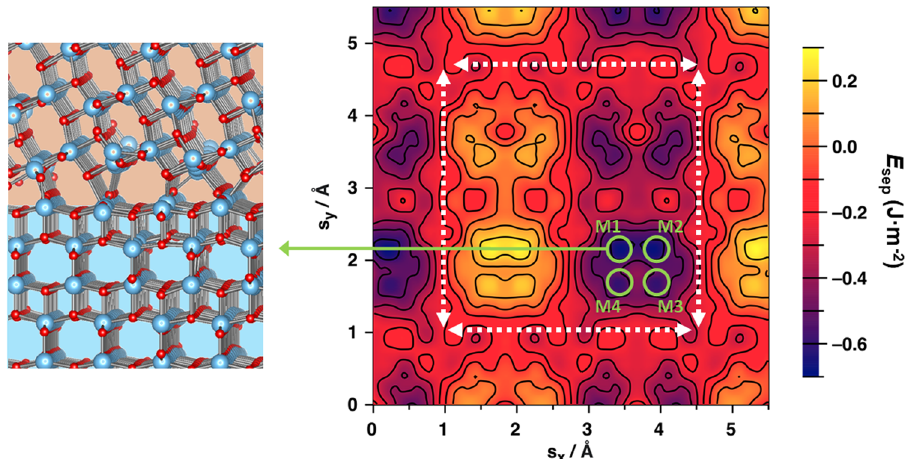
Fig.2|Anatase(101)/(001)relativeenergeticstabilitydisplacementmap. Right: E α =0° with respect to changing the x and y components of the sep values for shifting vector s . The white dashed arrows indicate a repeat region with local translationalsymmetryaccording to therelevantin-planelatticeparametersofthe